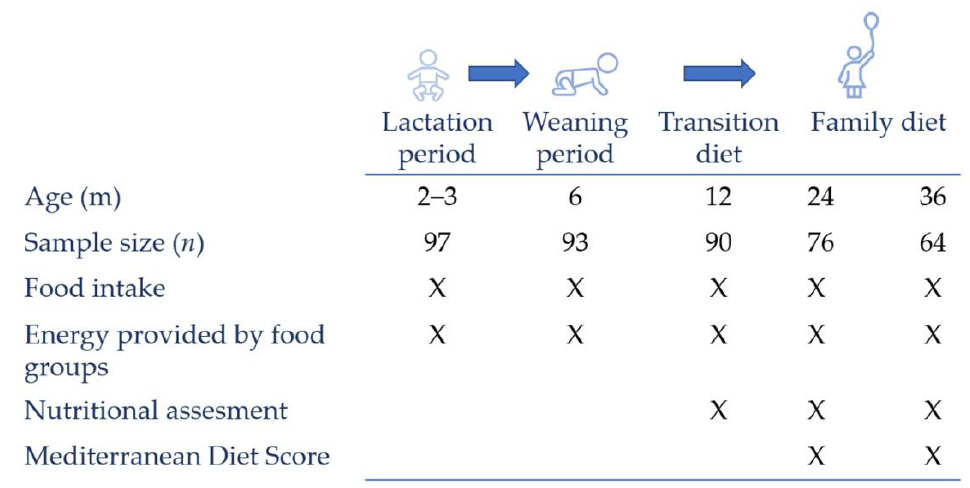
Figure 1. Study cohort and sampling points.X, data available.